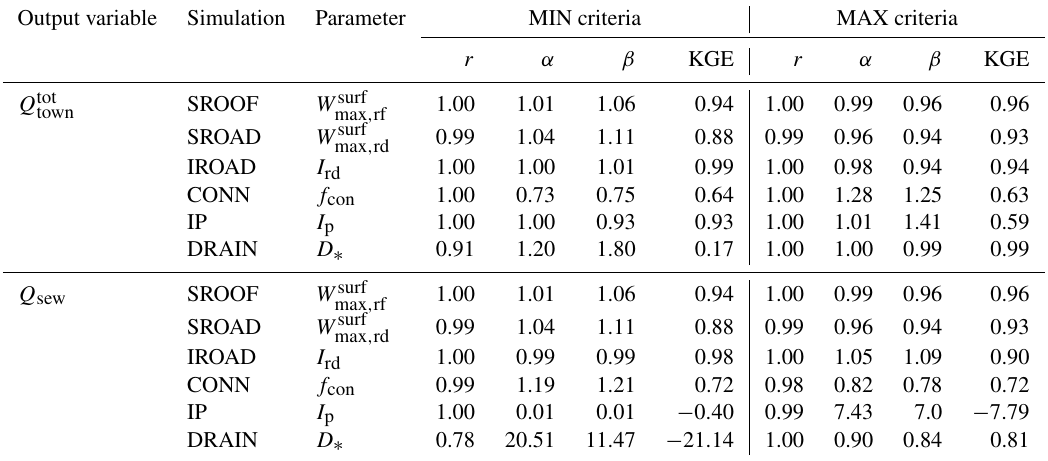
Figure 3. Comparison of total urban runoff ( R town ) between the reference simulation (REF) and both the MIN simulation (shown in blue) and MAX simulation (red) for the parameters (a) W surf (left side) and (b) W surf (right side). max , rd max , rf Table 3. Statistical criteria ( r , α , β , KGE) based on model output variables, as calculated between the MIN and MAX simulations, for each parameter and the reference simulation (REF). Output variable Simulation Parameter MIN criteria MAX